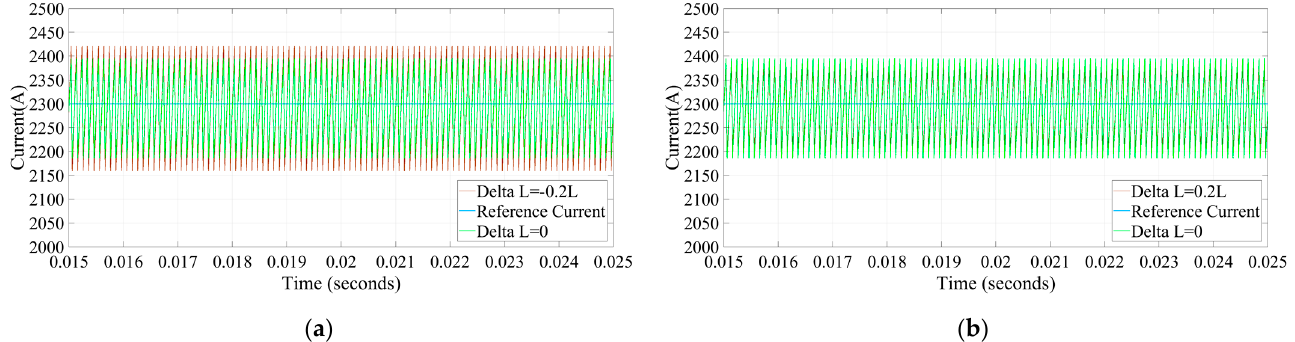
Figure 9. When the real inductance value is different from the control value. ( a ) Comparison of ∆ L = − 0.2 L and ∆ L = 0; ( b ) Comparison of ∆ L = 0.2 L and ∆ L = 0.